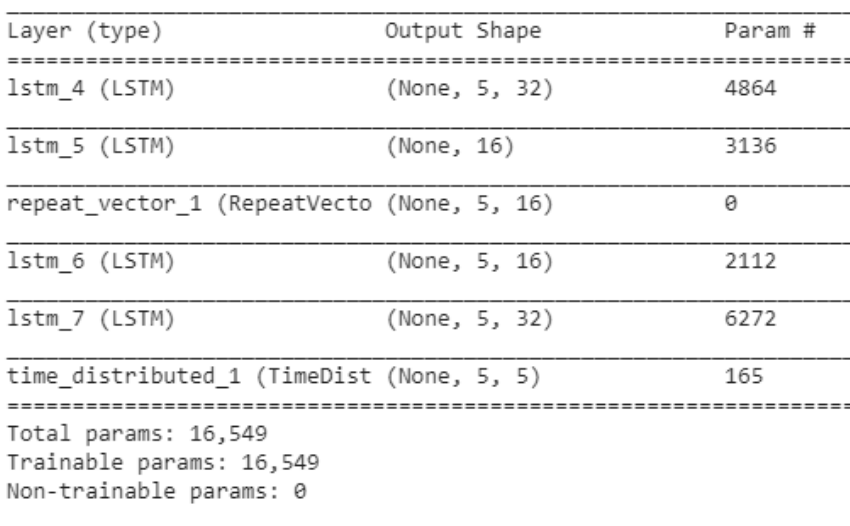
Figure 22. The dataset features distribution after scaling.